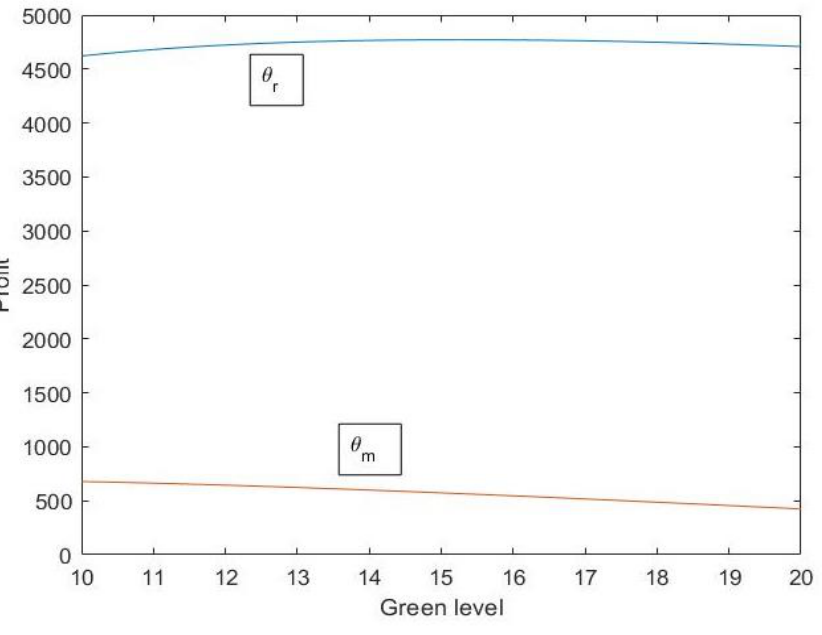
Figure 3. Graphical representation of changes of retailer’s and manufacturer’s profit with GQ.